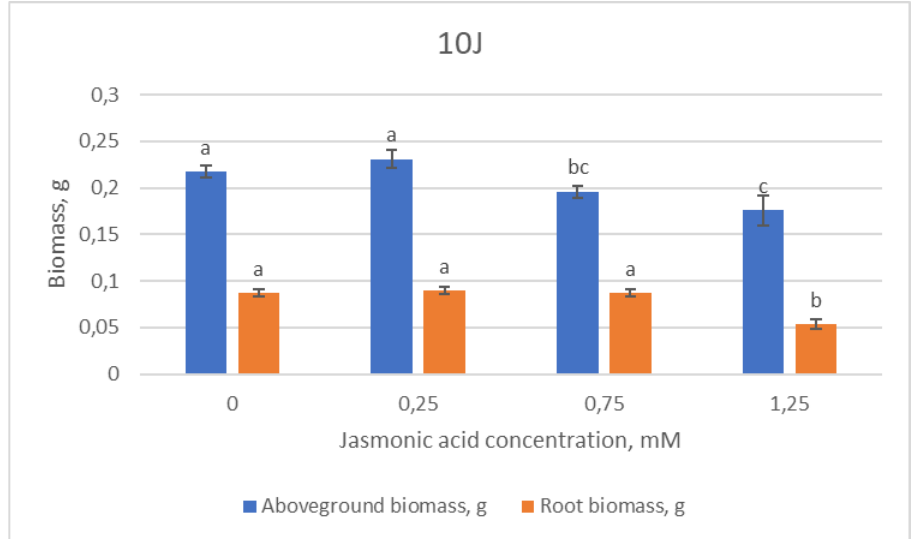
Figure 2. Means (g) ± SE of above-ground and root biomass of Scots pine half-sib family 10J, measured 6 weeks after sowing. Data significance was calculated using the Kruskal–Wallis H test for ranks and post hoc Dunn’s test for pairs ( p < 0.05). Different letters next to different colors indicate significant differences between the groups, sprayed with different concentrations of jasmonic acid.